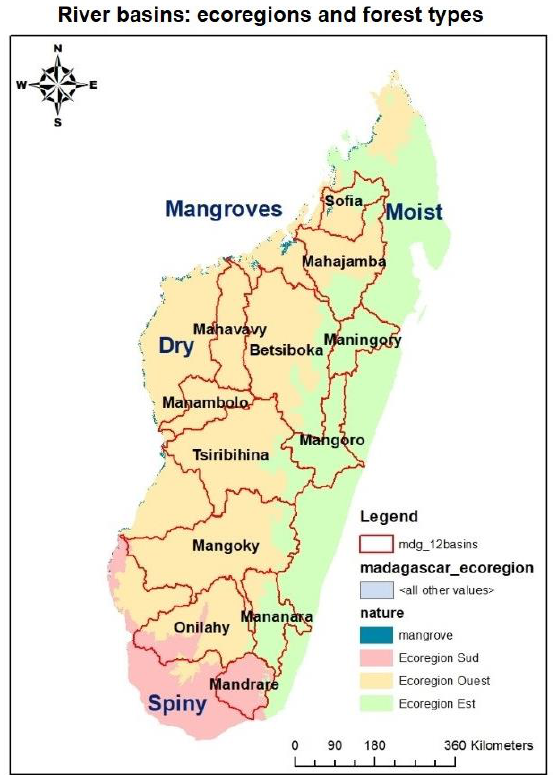
Figure 1. Delineation of catchment boundaries and ecoregions.